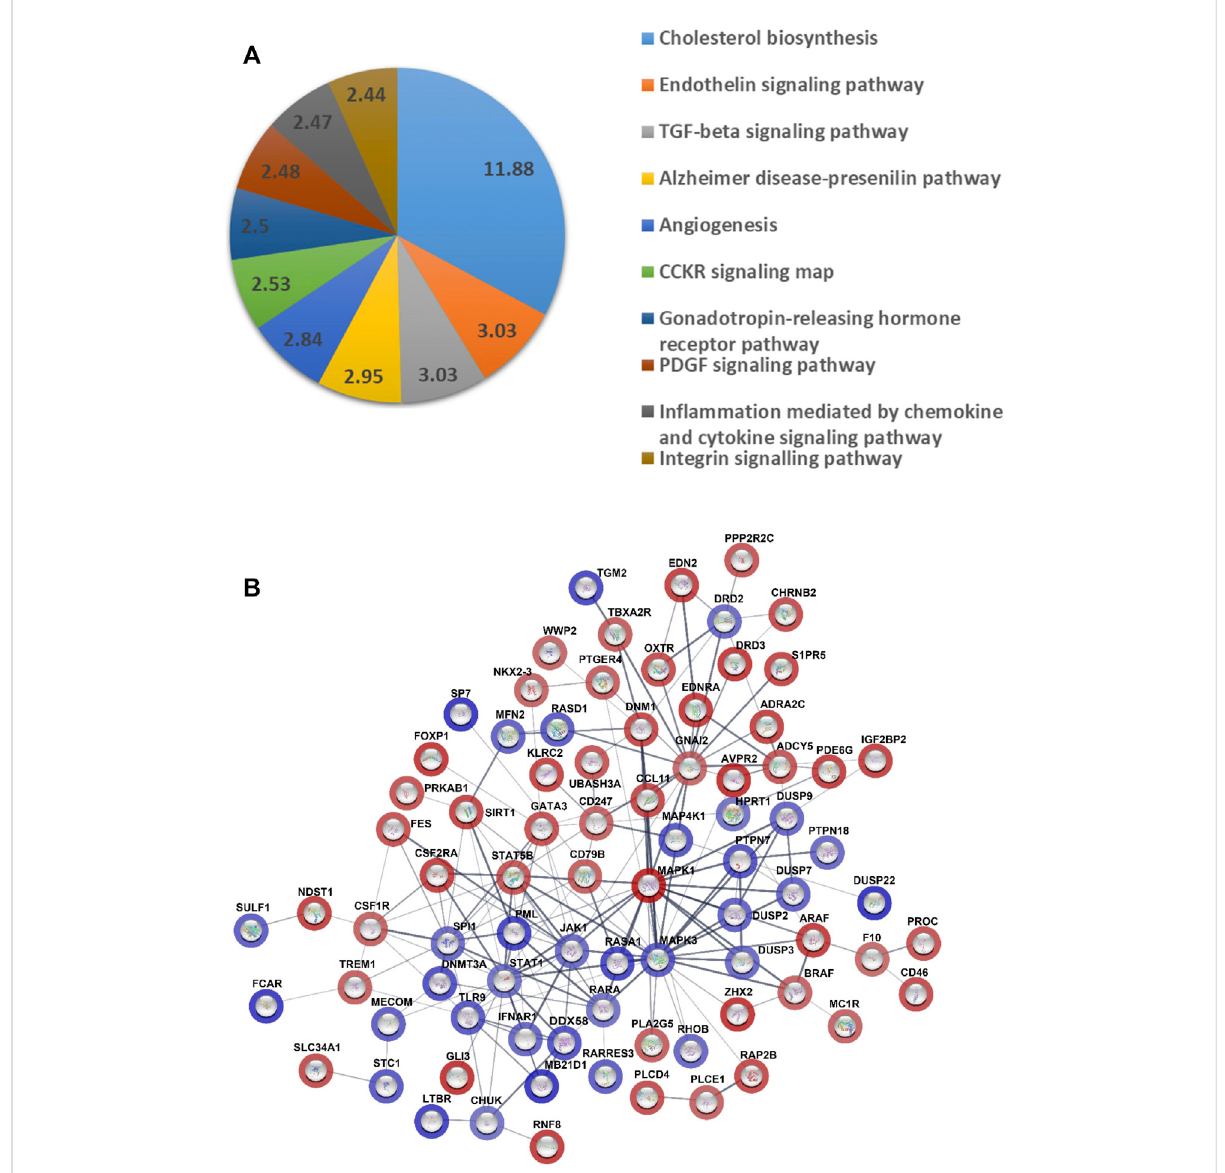
FIGURE 3 Analysis of gene expression data from microarray of the cells overexpressing GATA6 and control. (A) Pie chart of pathway gene analysis of differentially expressed genes. Analysis was done using PANTHER (17.0 Release). The numbers represent fold enrichment. Only results with false discovery rate < 0.05 are presented. (B) Prediction of master regulators was done by QIAGEN Ingenuity Pathway Analysis software. A Network of master regulator was done by STRING database (version 11.5). The color shades represent thedegree of activation/inhibition ranging from dark blue (most active) to dark red (most inhibited). The lines indicate the strength of data support such interaction. 17 master regulators were excluded from the network, since there was no evidence supporting any interaction with the other master